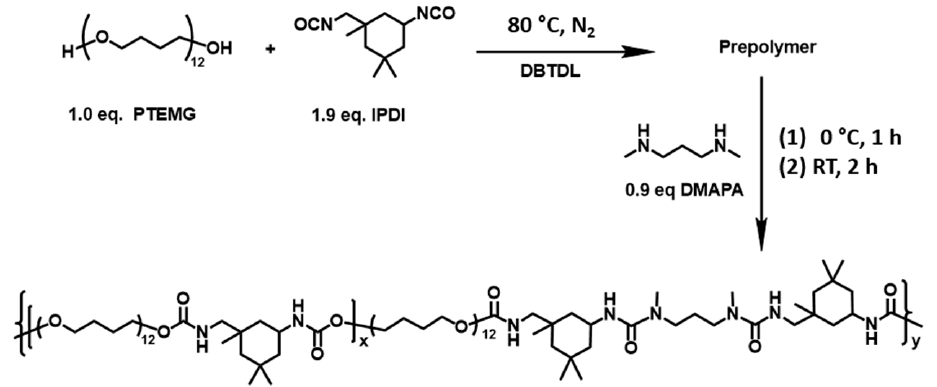
Figure 1. Synthesis of STPU and its chemical structure.